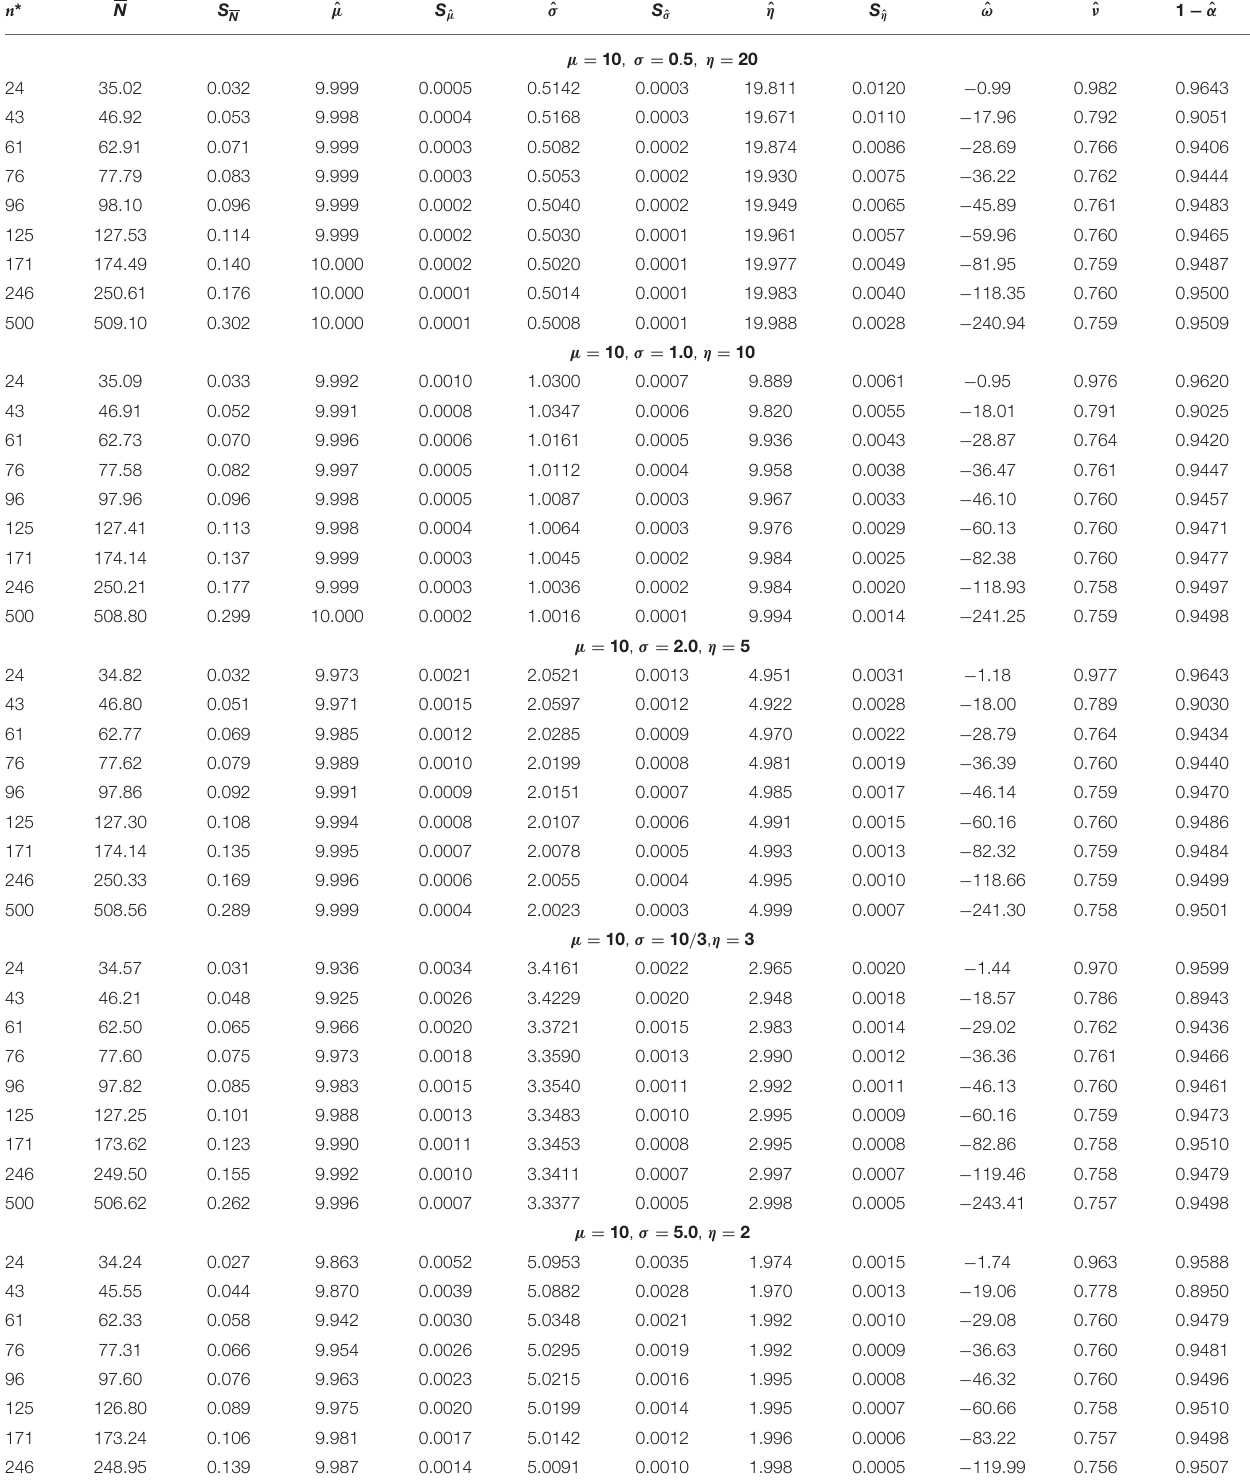
15, γ 0.5, α 5 % , η 20, 10, 5, 3, 2, 1.5, 1.0, and = = = =